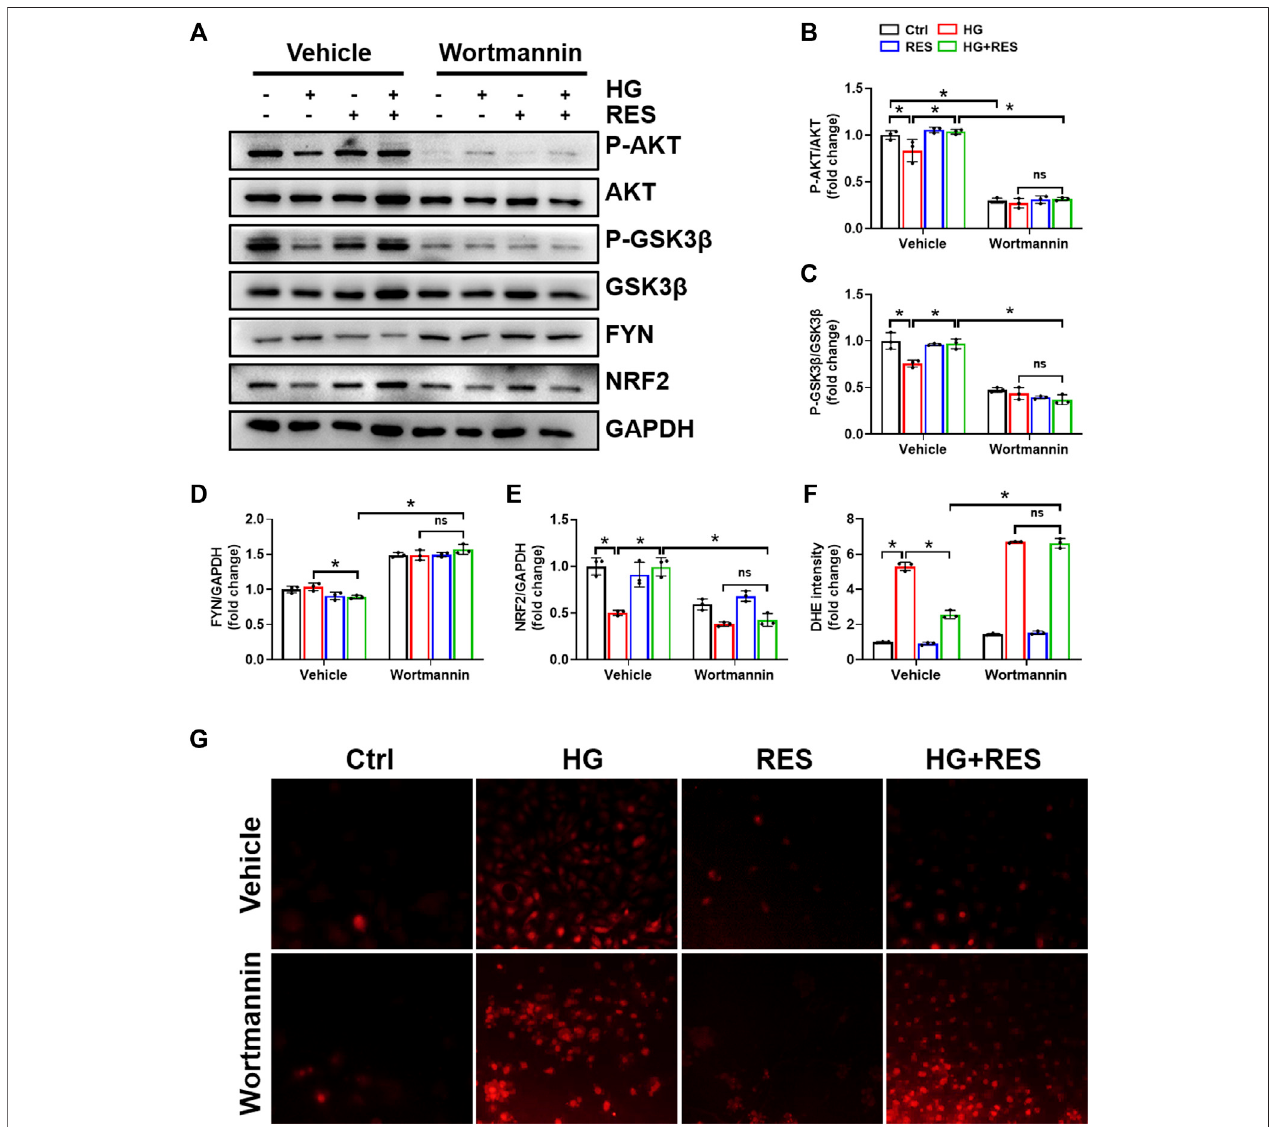
FIGURE6| WortmanninabolishedtheprotectionofRESonHG-inducedosteoblastdysfunction.MC3T3-E1cellswerepretreatedwithwortmannin(10 μ M)for6 h and then exposed to HG (30 mM) in the presence or absence of RES (5 μ M) for 24 h. (A – E) The protein expression of P-AKT, AKT, P-GSK3 β , GSK3 β , FYN, and NRF2 wasevaluatedbyWestern blotwithdensitometric quanti fi cation. GAPDHasaninternal control.Three independent experimentswereperformed. (F,G) ROSproduction was determined with the fl uorescent indicator DHE and measured by a fl uorescence microscope. Three independent experiments were performed. Data are shown as mean ± SD. * p < 0.05; ns indicates no signi fi